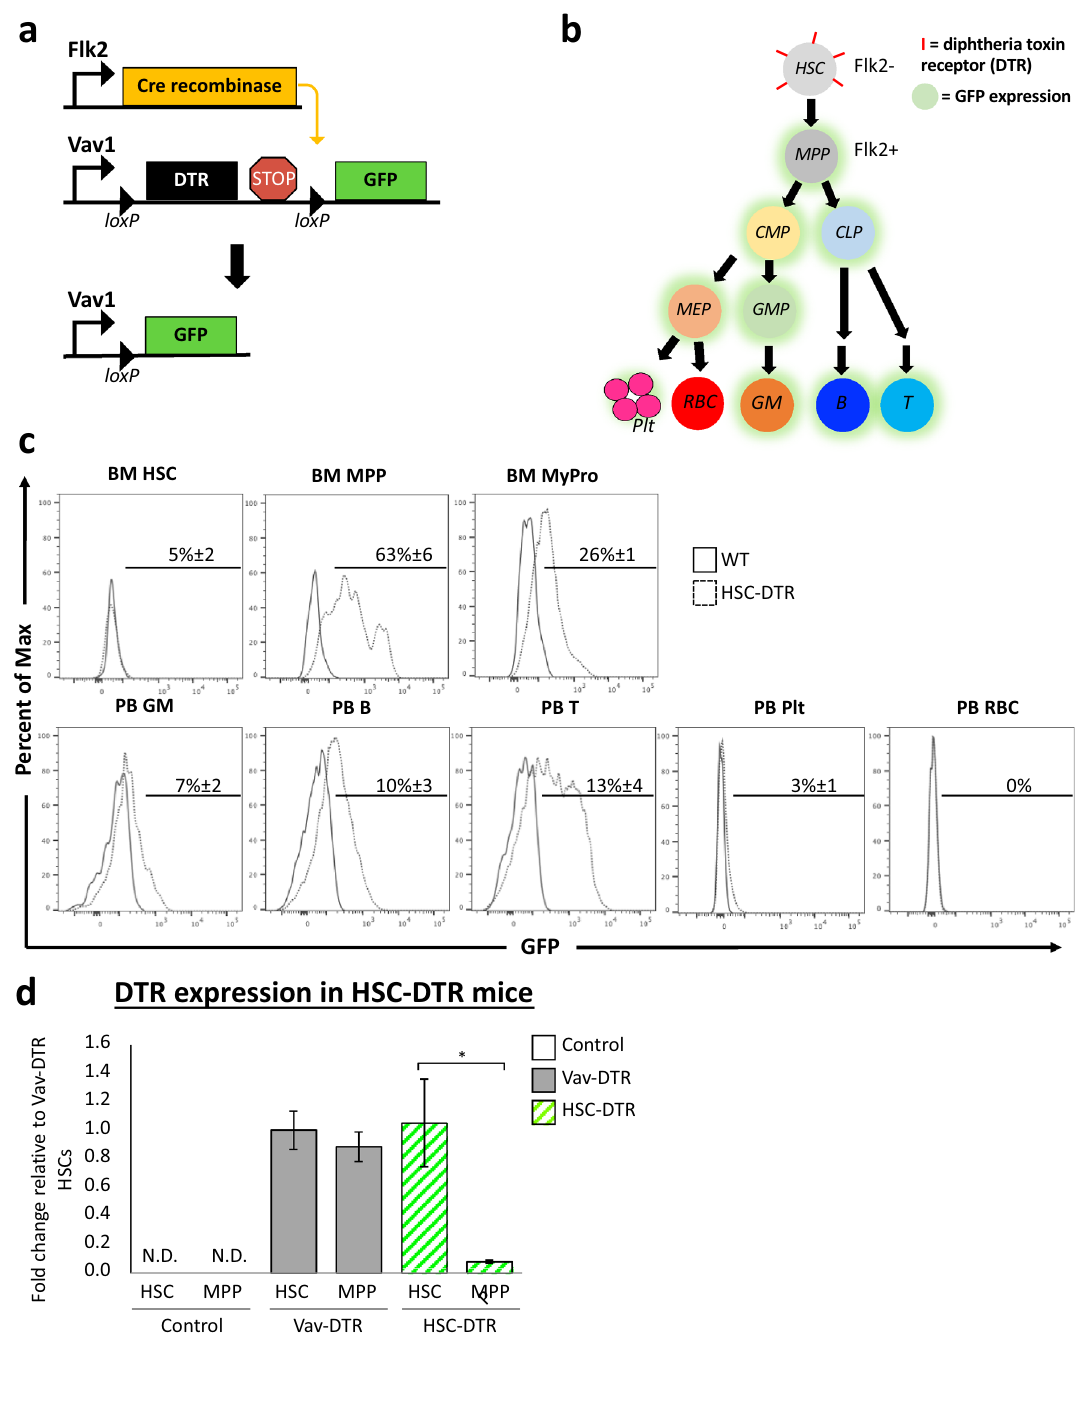
Figure 5. DTR expression is restricted to HSCs in HSC-DTR mice. ( a ) Flk2-Cre mice were crossed to Vav-DTR mice to generate “HSC-DTR” mice. ( b ) Simplified model of hematopoietic tree in HSC-DTR mice. Cell types that are Flk2+ or derived from Flk2+ progenitor cells should express GFP but not DTR, while Flk2− cells that have no history of Flk2 expression should express DTR and remain GFP−. ( c ) Representative histograms of flow cytometry data indicating GFP expression levels in BM and PB cells in WT mice (black line) and HSC-DTR mice (dotted black line). Percentages represent the frequency of cells labeled by GFP. ( d ) RT-qPCR analysis of DTR HSCs and MPPs sorted from control (white bars), Vav-DTR (gray bars), and HSC-DTR (white and green pattern bars) mice revealed that the DTR transgene is efficiently and significantly deleted in MPPs from HSC- DTR mice. Bar graph indicates the relative expression of DTR, normalized to β-actin. N = 6 mice. Error bars indicate SEM. *p < 0.05 (Student’s t-test). N.D not